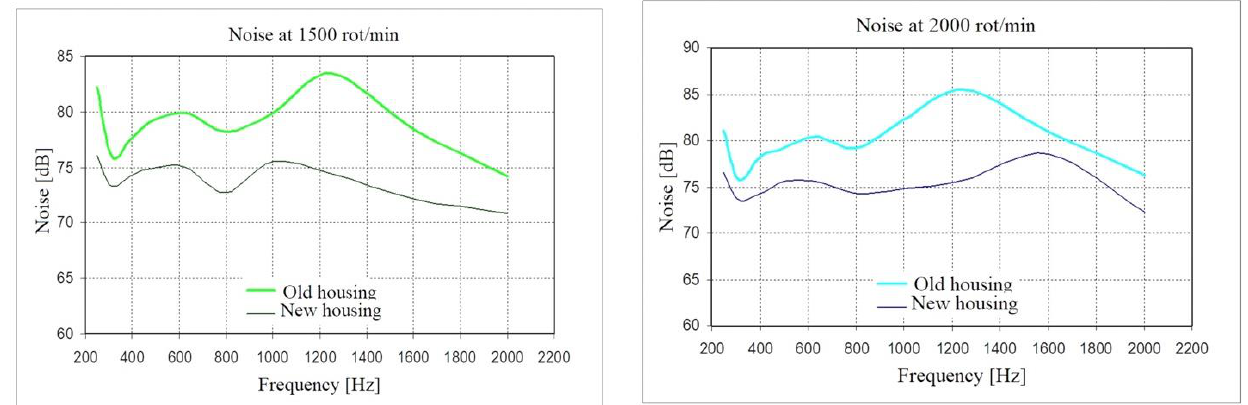
Figure 34. Lp sound pressure level diagrams for left side surface at 500 and 1000 rpm.